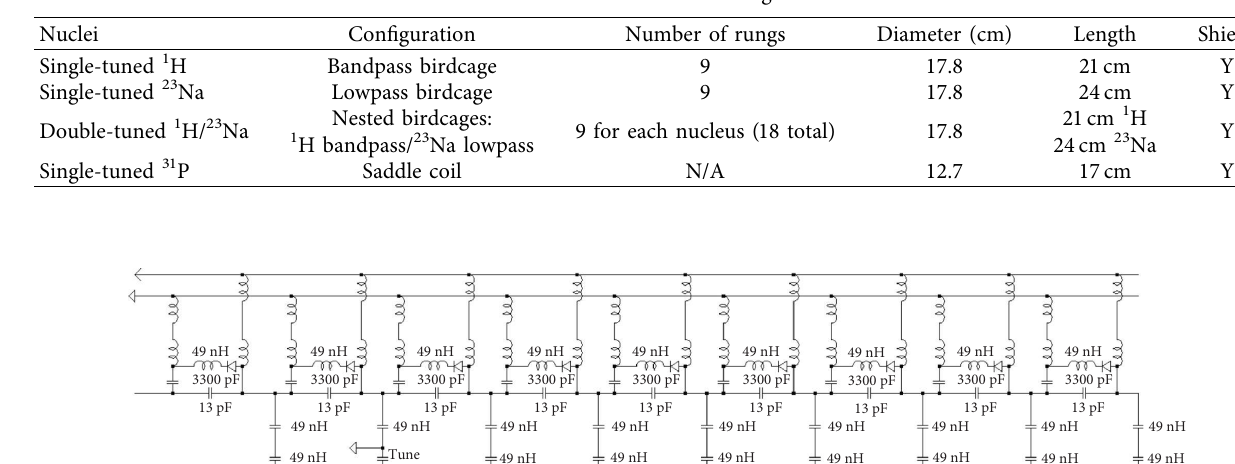
Table 1: Coil construction confgurations.